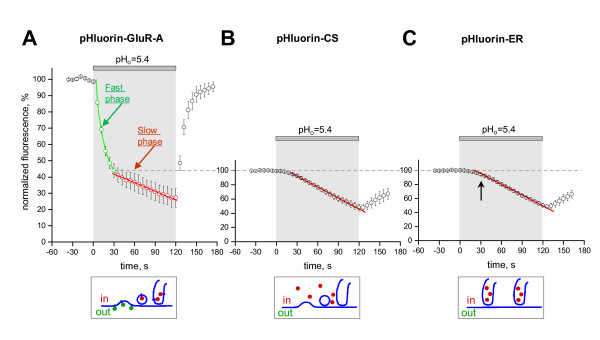
Biphasic changes in pHluorin fluorescence induced by application of acidic solution (pHo = 5.4). A, trace showing averaged time course of the pHluorin-GluR-A fluorescence quenching (normalized to the fluorescent intensity at the pre-application level). The initial, fast phase of fluorescence quenching is marked by green circles, the subsequent slow phase by red circles. Green and red lines represent best fitting curves for fast phase (exponential decay) and slow phase (linear regression), respectively. B, averaged time course of the cytosolic pHluorin (pHluorin-CS) quenching induced by application of acidic solution. The values are normalized to the fluorescence intensity at the pre-application level. Red line represents best linear fit for the plot. C, averaged time course of quenching of the pHluorin trapped in endoplasmic reticulum (pHluorin-ER) induced by application of acidic solution. Values are normalized to the fluorescence intensity at the pre-application level. Red line represents best linear fit for the plot. Note that the kinetics are similar both to these of pHluorin-CS (B) and to the slow phase of pHluorin-GluR-A fluorescence quenching (red circles in A). Schematic representation of the cellular localization of pHluorin-tagged molecules for each of the construct is shown at the bottom of each panel.